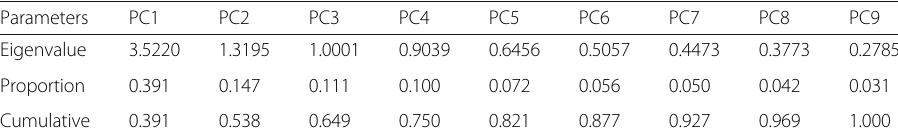
Table 3 Eigen analysis of the correlation matrix Parameters